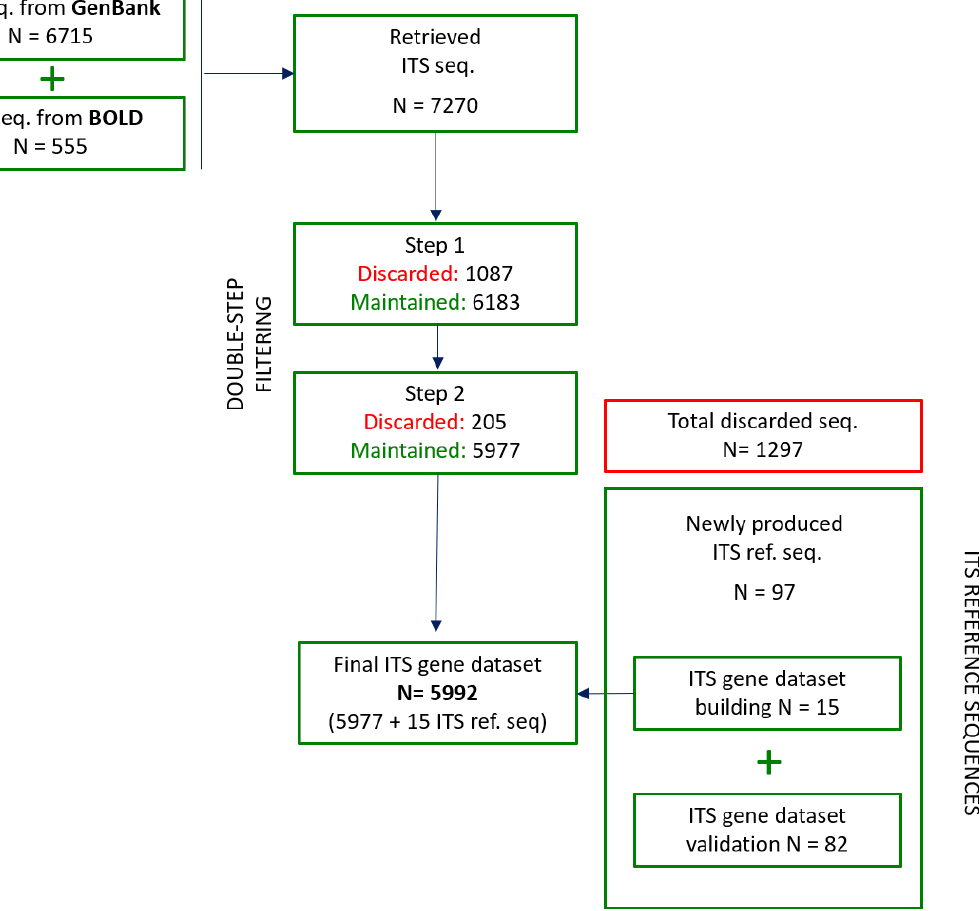
Figure 1. Diagram of the ITS gene dataset building process. The ITS sequences retrieved from public databases and their systematic double-step filtering process, as well as the ITS reference sequence production, are reported.